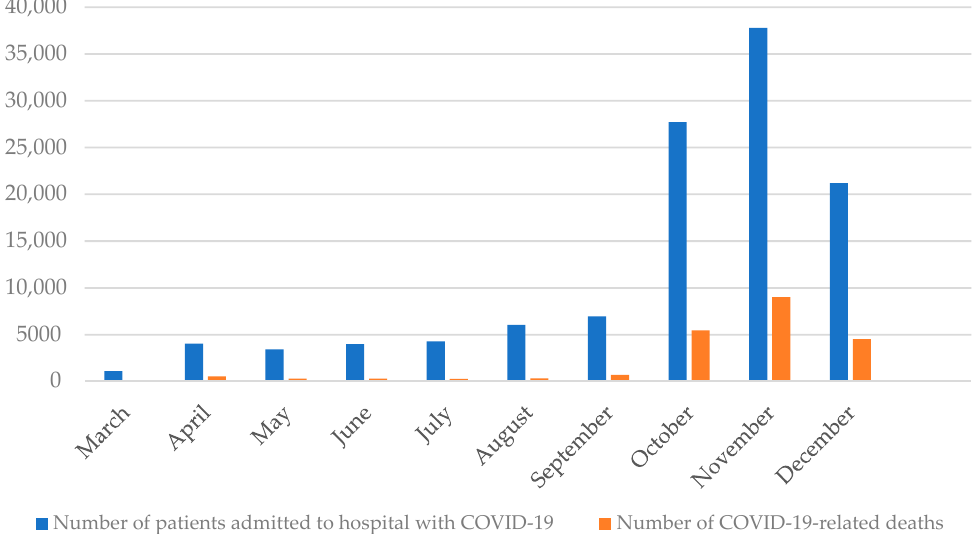
Figure 1. Number of patients admitted to hospital with COVID-19 and deaths in